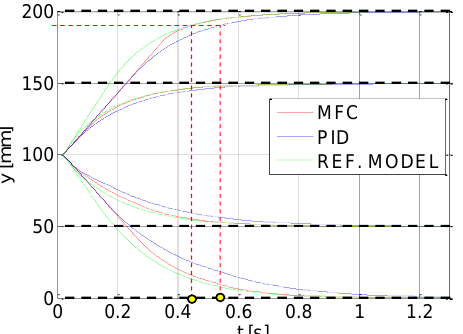
Figure 5. Step responses of the EHSD for MFC and PID controllers ( F = 10 000N); p 0 = 12 MPa.